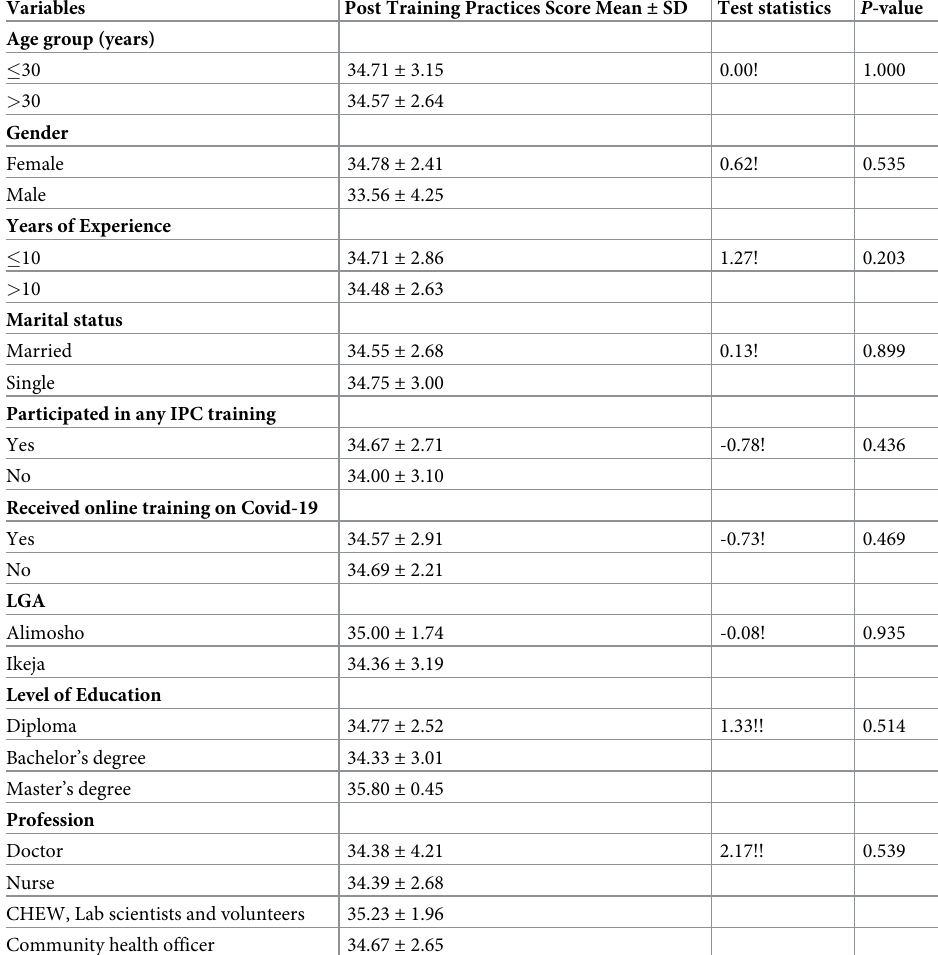
Table 5. Association between the socio-demographic characteristics of the health workers and COVID-19 preven- tion practice